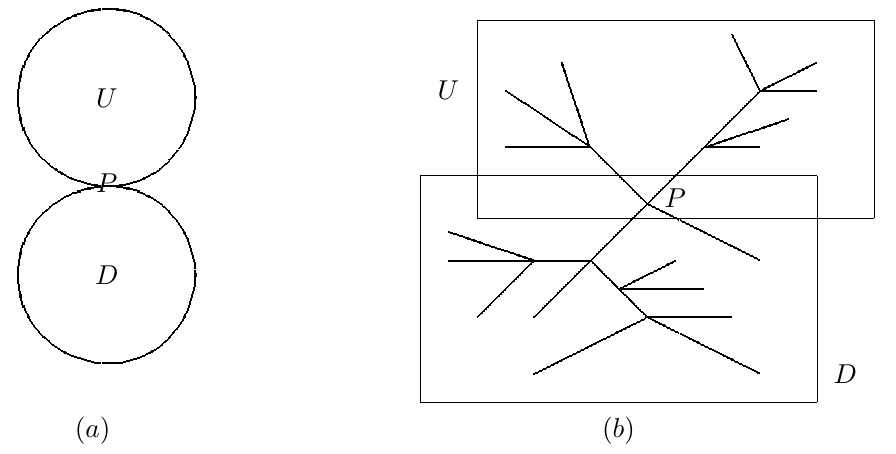
Figure 19 . (a) Schematic representation of a generic connected tree diagram in which the blobs U and D themselves are connected tree diagrams. (b) Example of such a generic connected tree